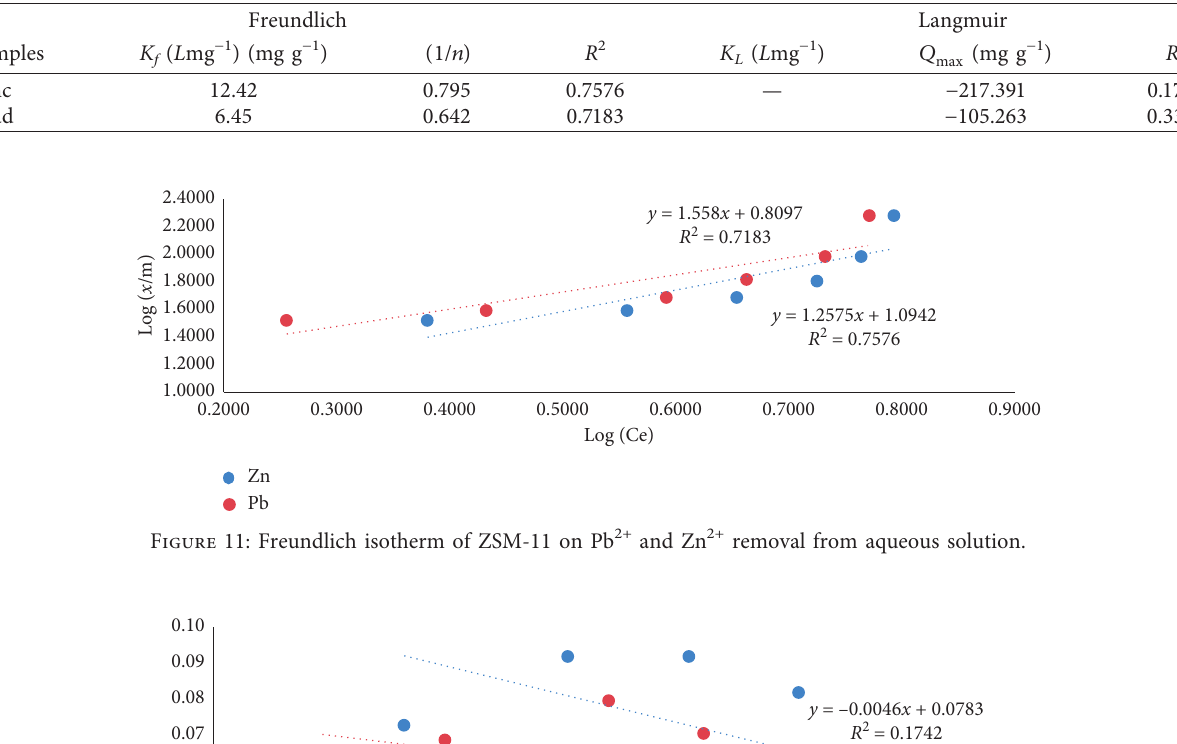
Table 5: Adsorption isotherms parameters for zinc and lead to ZSM-11.